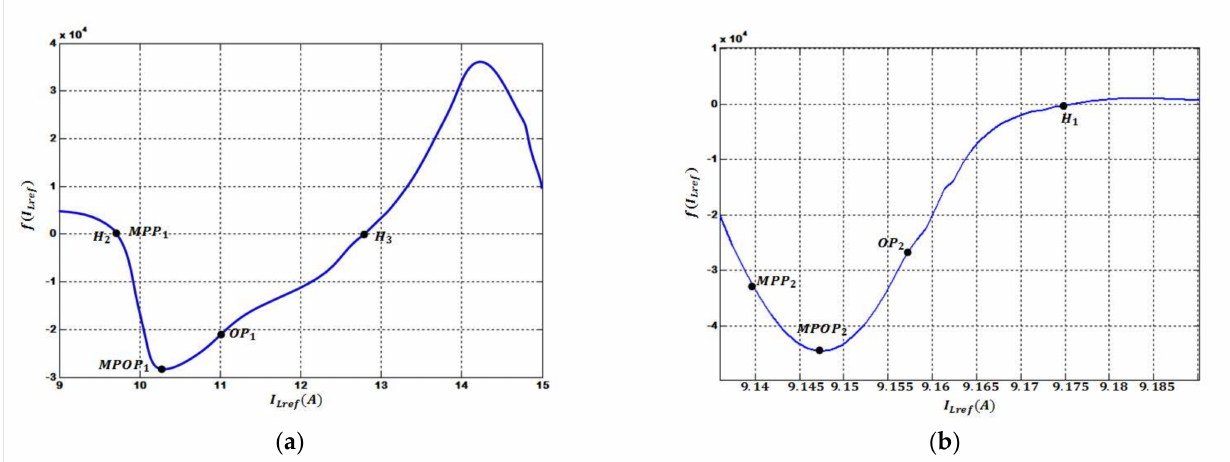
Figure 8. Evolution of function f(I Lref ) and stability analysis of operating points. ( a ) cost function for region 1; ( b ) cost function for region 2.